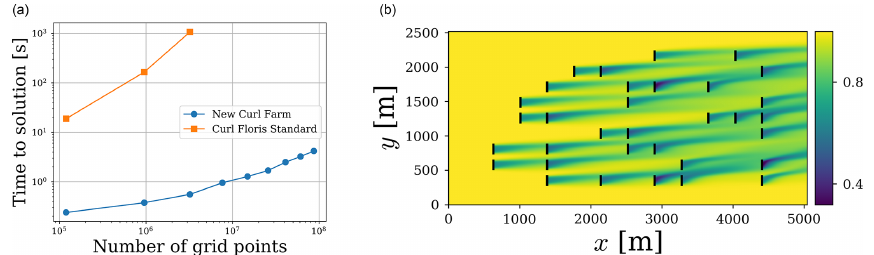
Figure 2. Scaling of the computational algorithm (a) based on a representative wind plant composed of 36 turbines with wake steering (b) .